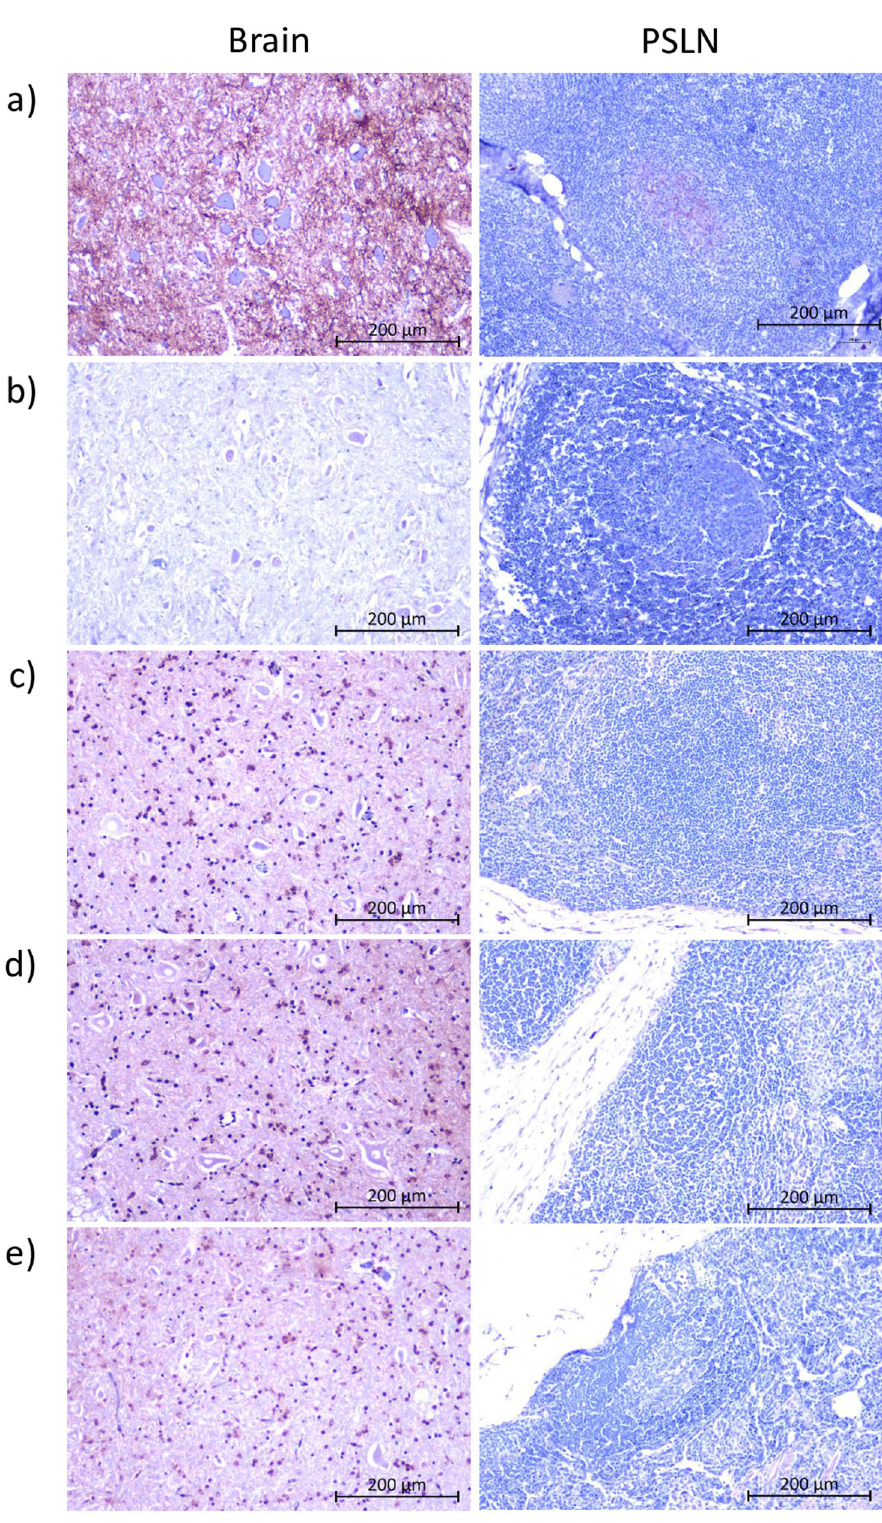
Figure 3. Immunohistochemical labelling of multiple sections of PSLN and brain from pathology negative sheep for PrP Sc . Sections of PSLN and brain medulla (at the level of the obex) were cut from the same block at five different levels 50 µm apart, and IHC performed with monoclonal antibody BG4. Representative results from one sheep (Q397) are shown. ( a ) Positive control sections from BSE-infected pathology positive sheep; ( b ) negative control sections from mock-infected sheep; ( c – e ) three sections cut at least 50 µm apart. Scale bars = 200